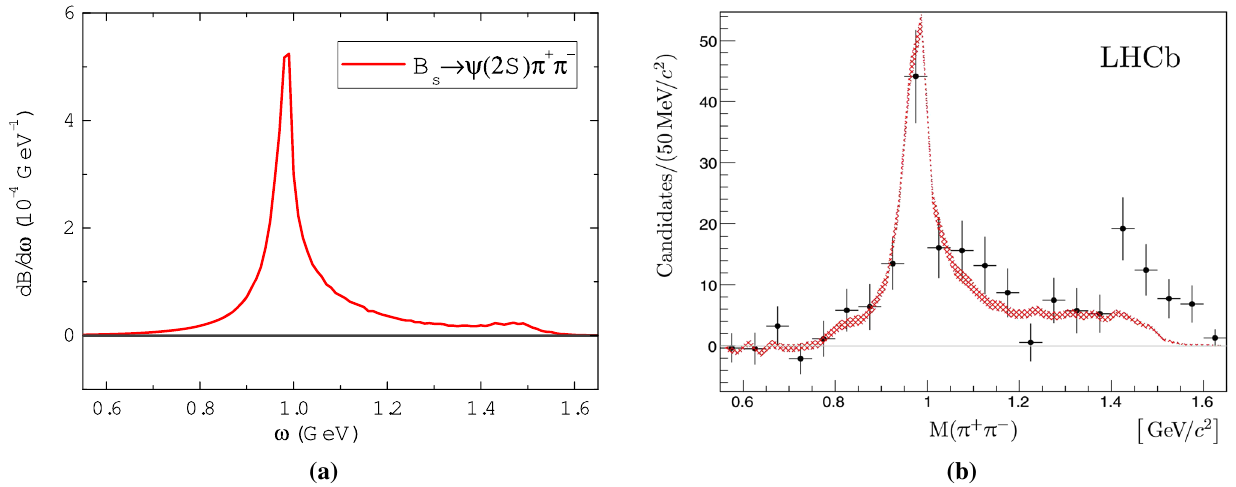
Fig. 3 π + π − invariant mass distributions for the B 0 s → ψ( 2 S )π + π − decay. a The S-wave contributions in this work, and b from the LHCb Collaboration [57] Table 2 Contributions to the branching ratios (in unit of 10 − 5 ) of B 0 s → ψ( 2 S , 3 S )π + π − decays from the factorizable amplitudes F , from the nonfactorizable amplitudes M , and from the interference between F and